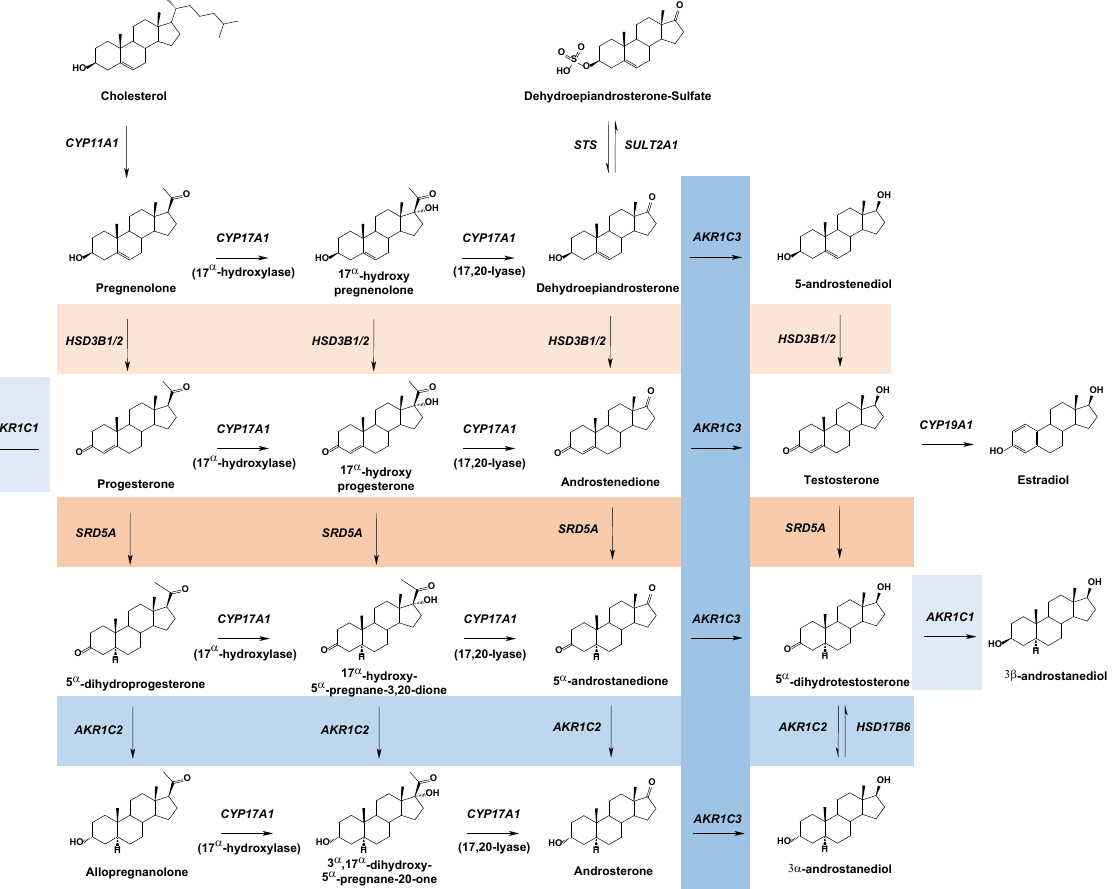
Figure 1. Human sex steroid hormone metabolism with short-chain dehydrogenases/reductase enzymatic conversions influenced by germ-line mutations. AKR family members reviewed in the present work are shaded in blue, while non-AKR family members previously reviewed are shaded in orange.